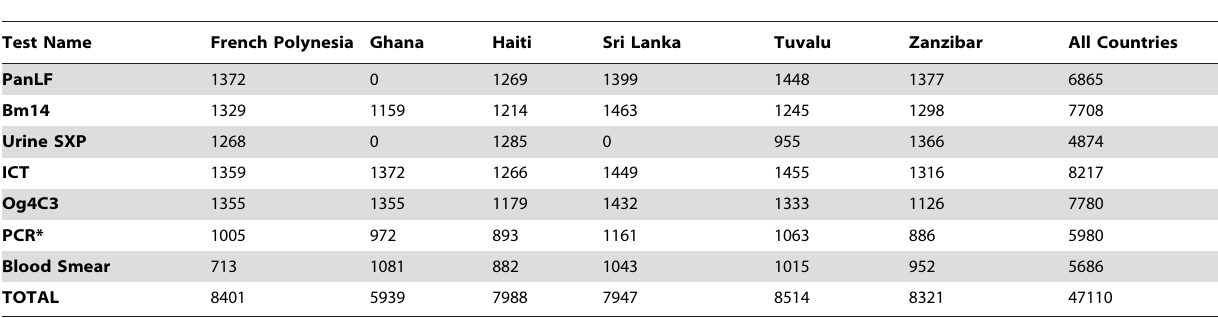
Table 4. Specimens and tests performed by country of origin.